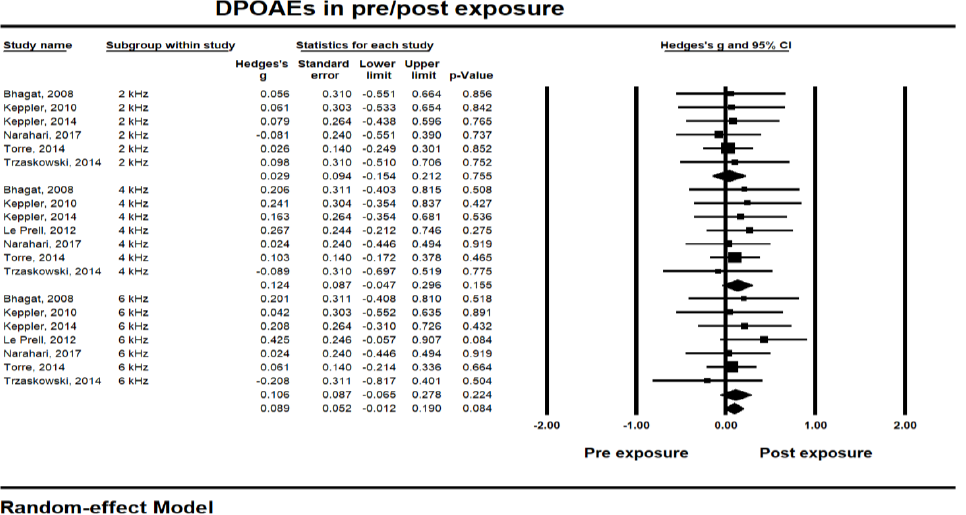
Figure 3. Short-term hearing changes in distortion product otoacoustic emissions (DPOAEs) amplitude at 2, 4, and 6 kHz center frequencies within 24 h after music exposure.